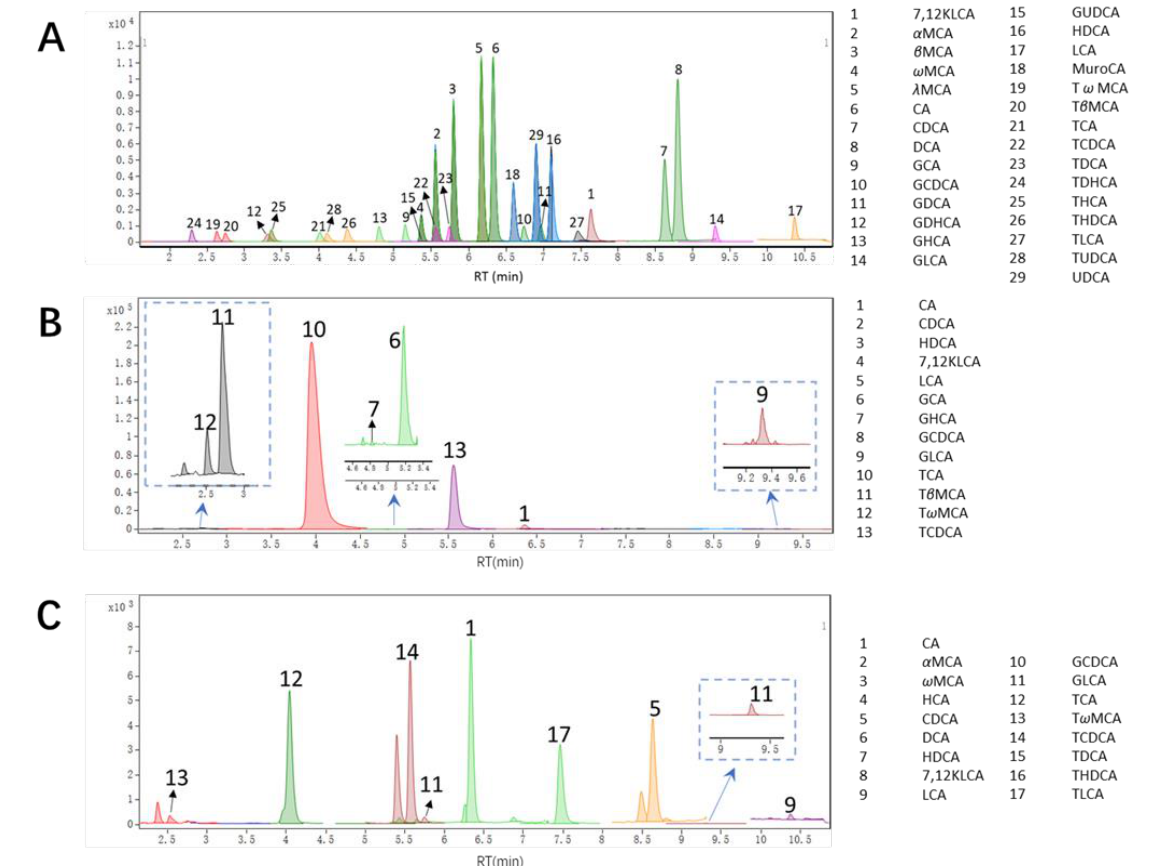
Figure 4. Bile acids Extracted Ion Chromatogram (EIC) in sample and standard; the peak times between bile acids do not interfere with each other. ( A ) is standard EIC, ( B ) is for bile sample, and ( C ) for plasma sample.